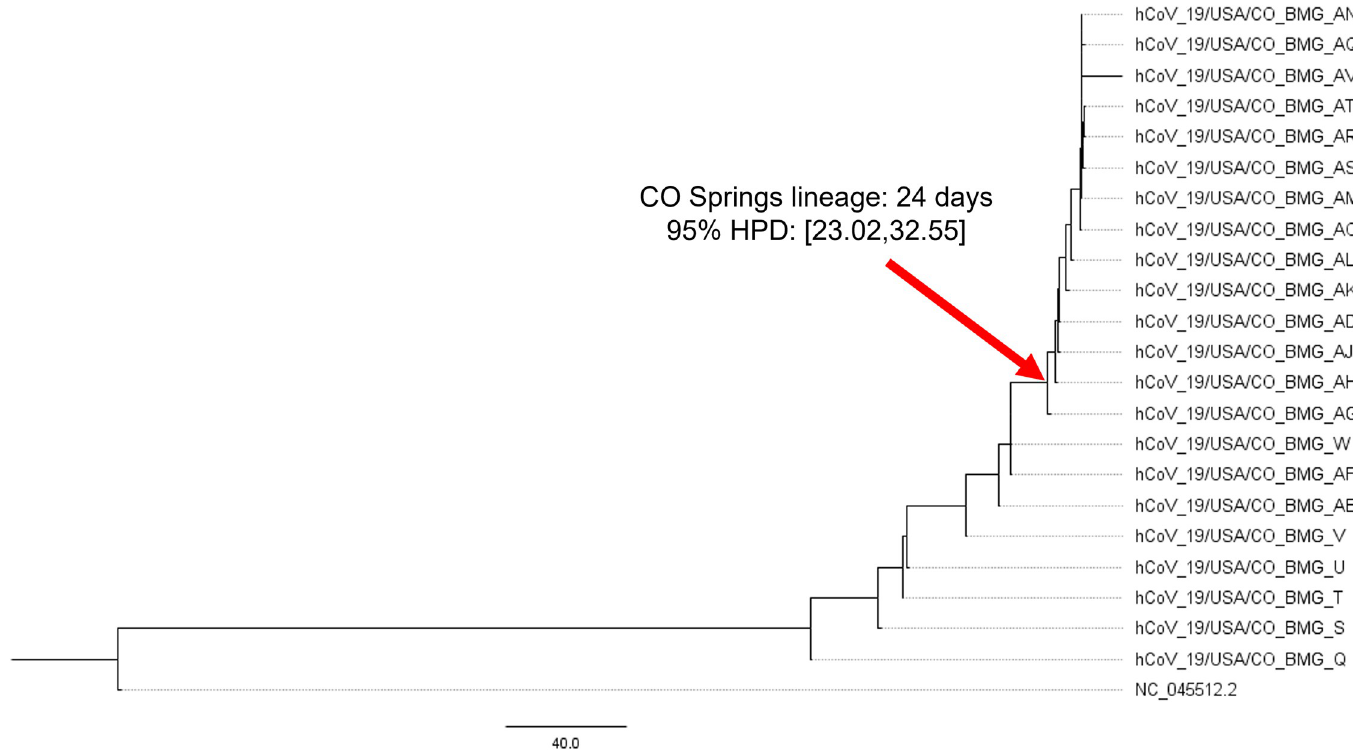
Fig 5. Divergence estimates indicate that the CO Springs lineage originated around October 26 th , 2020. The red arrow indicates the node where the CO Springs lineage branches off from ancestral nodes. 95% HPD and tree distances are in units of “days before November 19, 2020”.